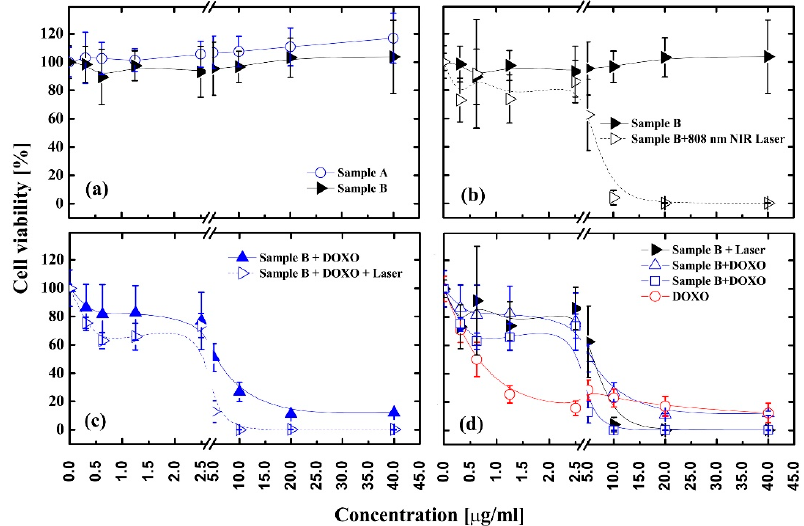
Figure 7. Cell viabilities of HepG2 cells after being incubated with different nanomaterials at various concentrations. ( a ) Sample A—Fe 3 O 4 @PDA and Sample B—Fe 3 O 4 @PDA@SH- β CD; ( b ) Sample B—with and without laser irradiation; ( c )Sample B—loaded with DOXO with and without laser irradiation; ( d ) Replotted data from ( b , c ) plus free DOXO as the reference.